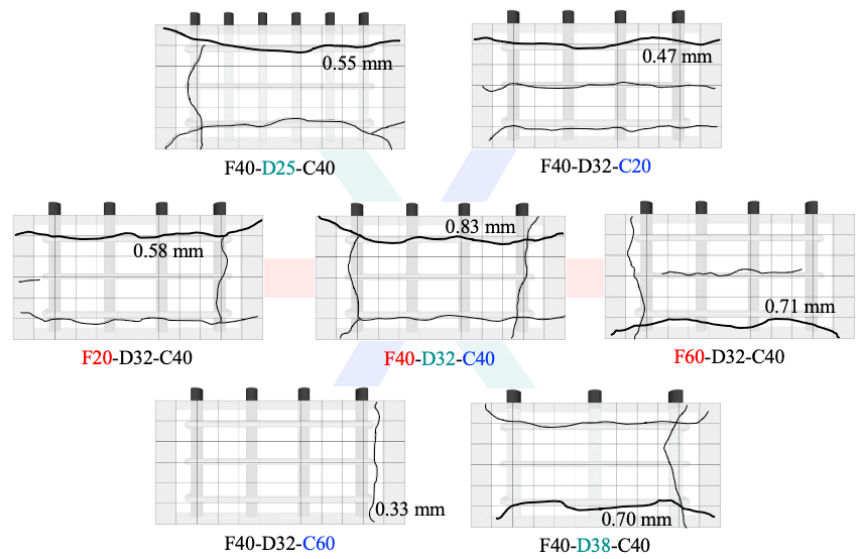
Figure 9. Crack patterns at the final stages of corrosion testing.